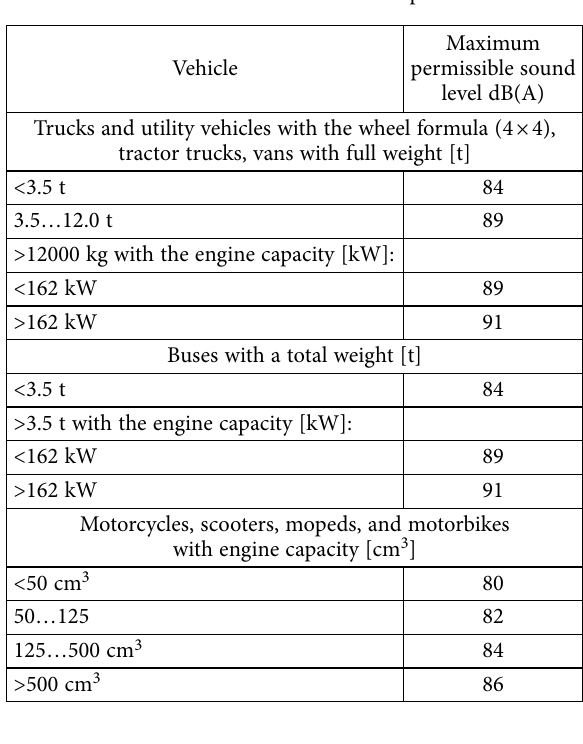
Increased roughness of the road